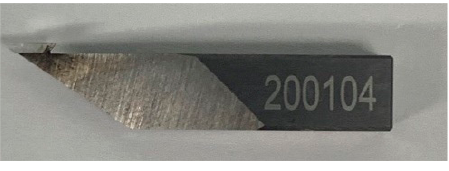
Figure 9. Diamond tool.